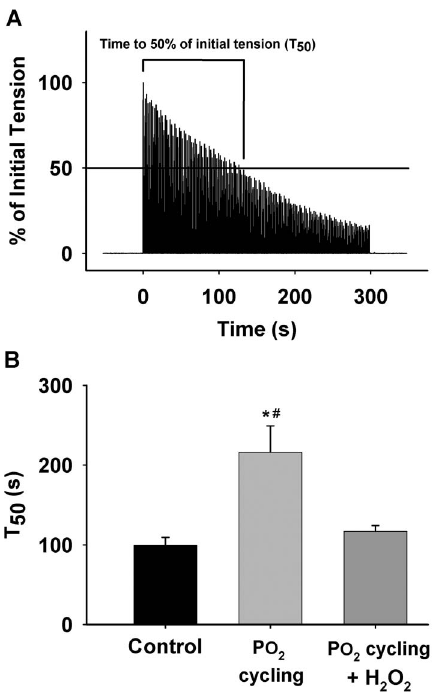
Figure 4. Time to reach 50% (T 50 ) of the initial tension in contracting diaphragm muscle under 40 Torr PO 2 . A: a typical chart record illustrating the duration of T 50 in a contracting diaphragm muscle during a 5-min contraction period. B: summarized T 50 values from control, PO 2 cycling, and PO 2 cycling + H 2 O 2 (50 m M) groups during the contraction (*significantly different from control, P , 0.05; # significantly different from PO 2 cycling + H 2 O 2 , P , 0.05).